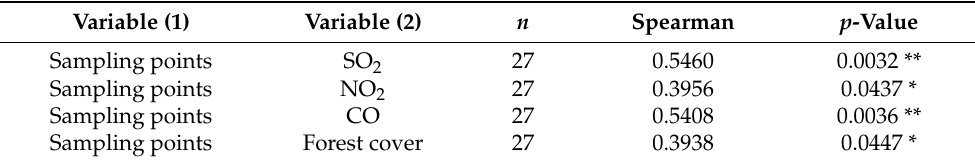
Table 2. Significant correlations between the variables studied and the sampling points (Note: *, or ** indicate significant nonlinear dependencies at the 5%, or 1% levels,